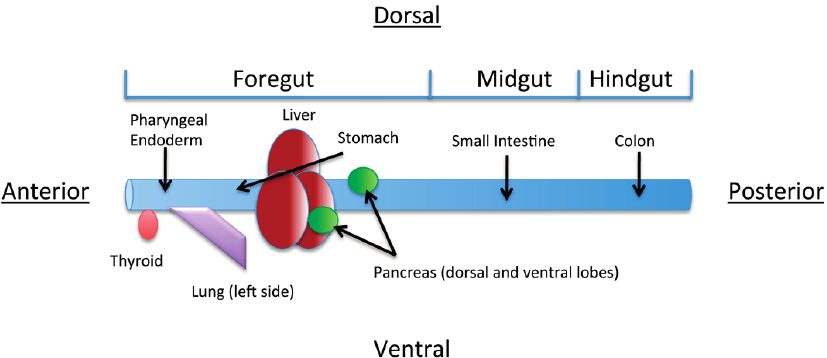
Figure 1. Derivatives of the endoderm form along the gut tube in a precise anterior to posterior order. The gut is first divided into broad regions of foregut, midgut, and